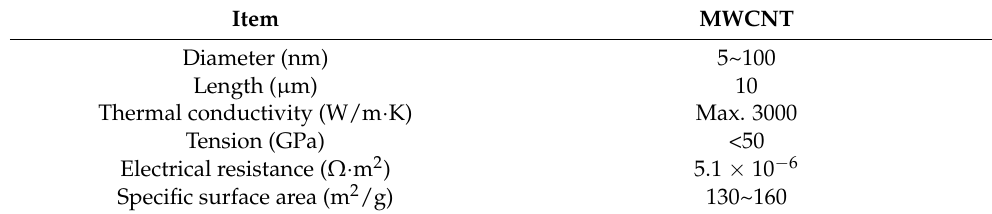
Table 2. Physical properties of MWCNT.